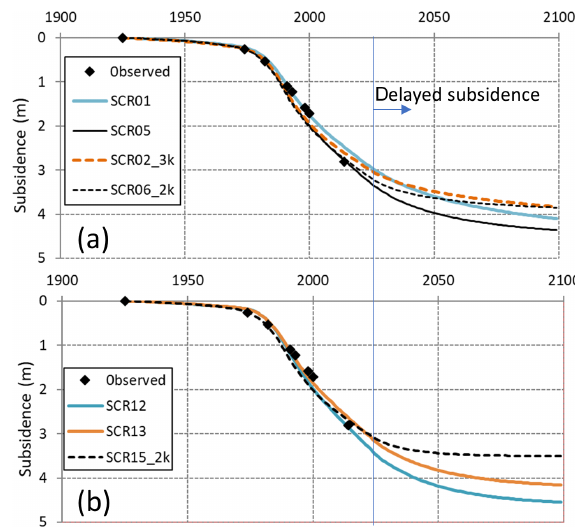
Figure 4. Observed and modelled subsidence. (a) IM-runs with non-zero secondary compression ratio. (b) TM-runs; IM model in elastoplastic mode (zero secondary compression ratio).